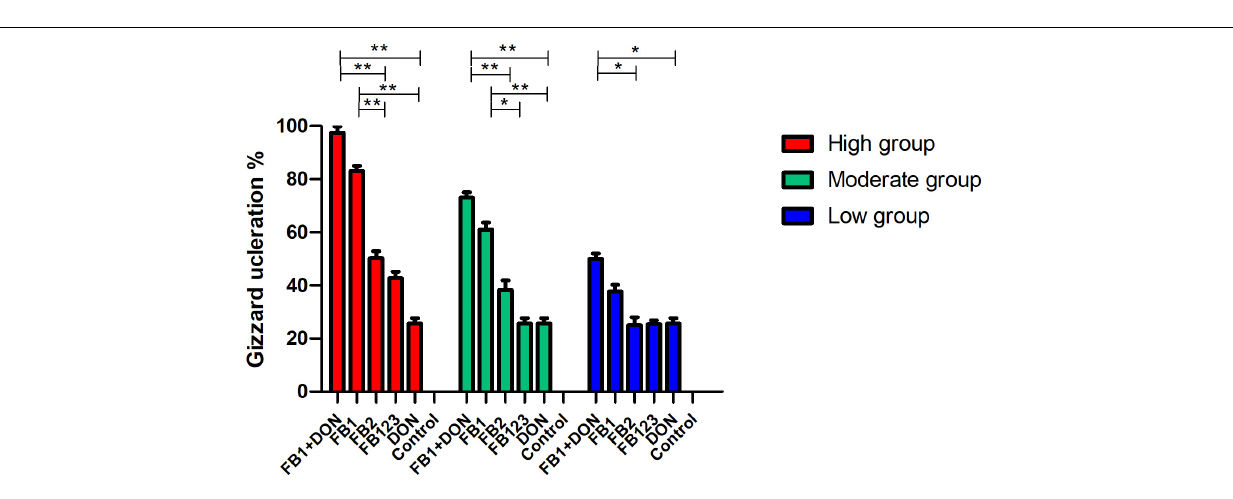
FIGURE 3 | Percentage of gizzard ulceration of chicken progenies post-inoculation with FB 1 or DON, or synergetic inoculation. Post-mortem, both the high FB 1 + DON group and the high FB 1 group developed higher lesions of gizzard ulcerations compared to the high FB 2 group, or the high FB 1 + FB 2 + FB 3 group or the DON group ( p < 0.01), while significant difference was found in the moderate FB 1 + DON group compared to the moderate FB 2 group, or the moderate FB 1 + FB 2 + FB 3 group or the DON group ( p < 0.01). As for the moderate FB 1 group, a statistical difference was found compared to the moderate FB 2 group, the moderate FB 1 + FB 2 + FB 3 group, and the DON group ( p < 0.05). The data were expressed as the mean ± SD. * p < 0.05; ** p <